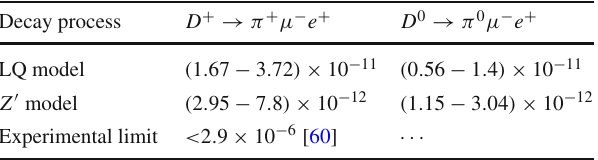
Table 3 The predicted branching ratios for D + ( 0 ) → π + ( 0 ) μ − e + lepton flavour violating processes in the scalar X ( 3 , 2 , 7 / 6 ) LQ and Z (cid:2) model. The present upper limit on the branching ratio BR ( D 0 → π 0 μ ∓ e ± ) = BR ( D 0 → π 0 μ − e + + π 0 μ + e − ) < 8 . 6 × 10 − 5 [60]